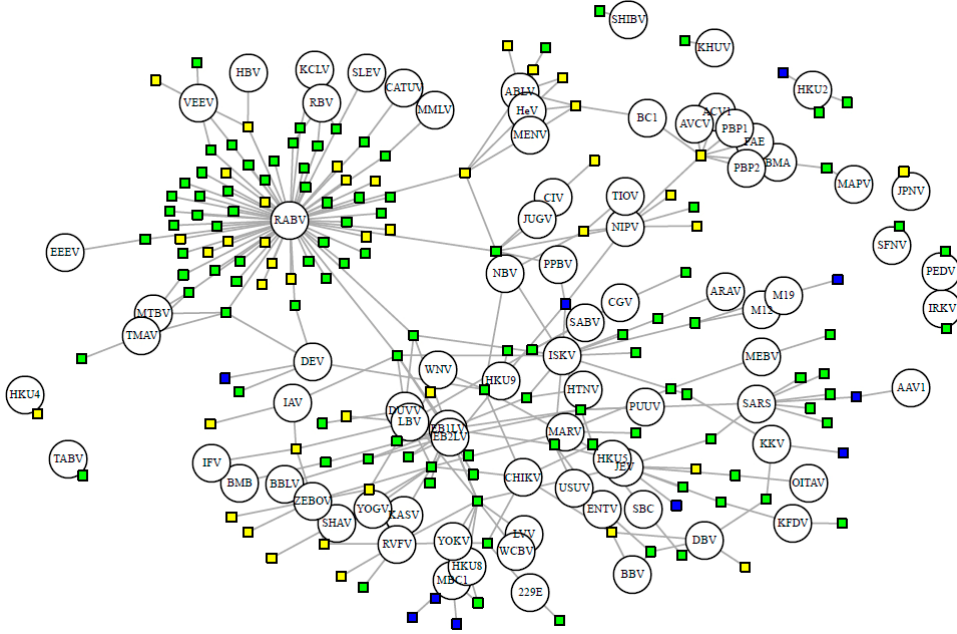
Figure 3. Bipartite network of bat hosts (squares, n = 153 species) and PCR-detected viruses (circles, n = 82 species). Connected by 277 associations. Cave-roosting bats are shown in green (facultative, n = 102) and blue (obligate, n = 10), while non-cave-roosting species are shown in yellow. Viral abbreviations are listed with ICTV species name in Supplementary Table S1.